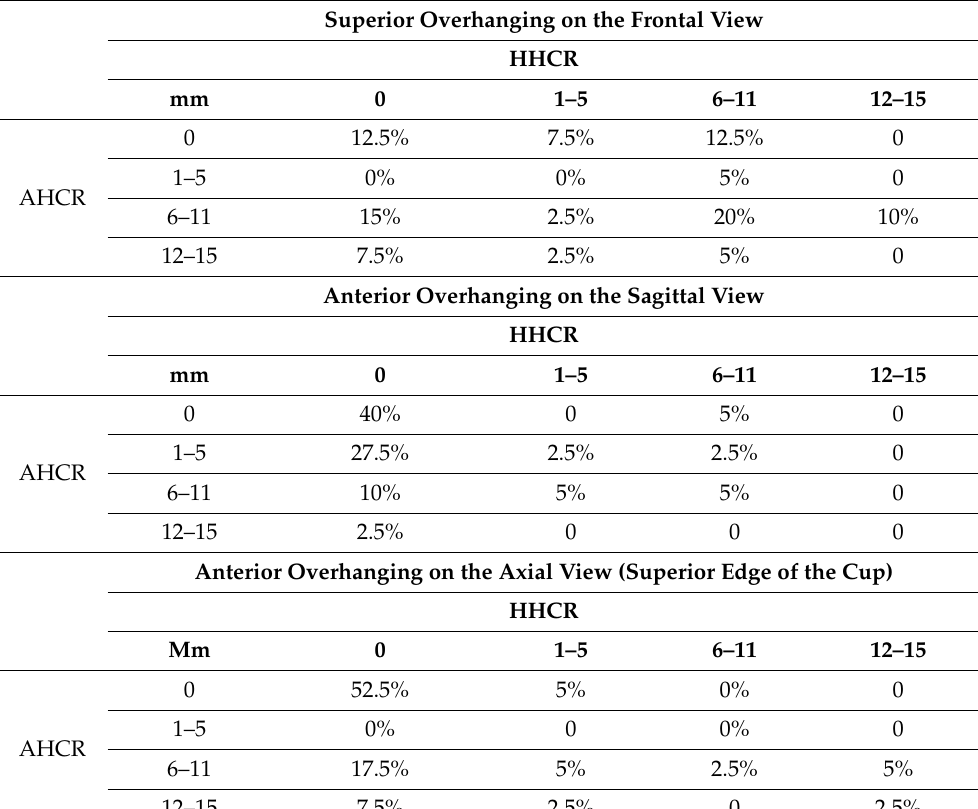
Table 1. Cup prominence on every considered plane were stratified according to the entity and the AHCR and HHCR